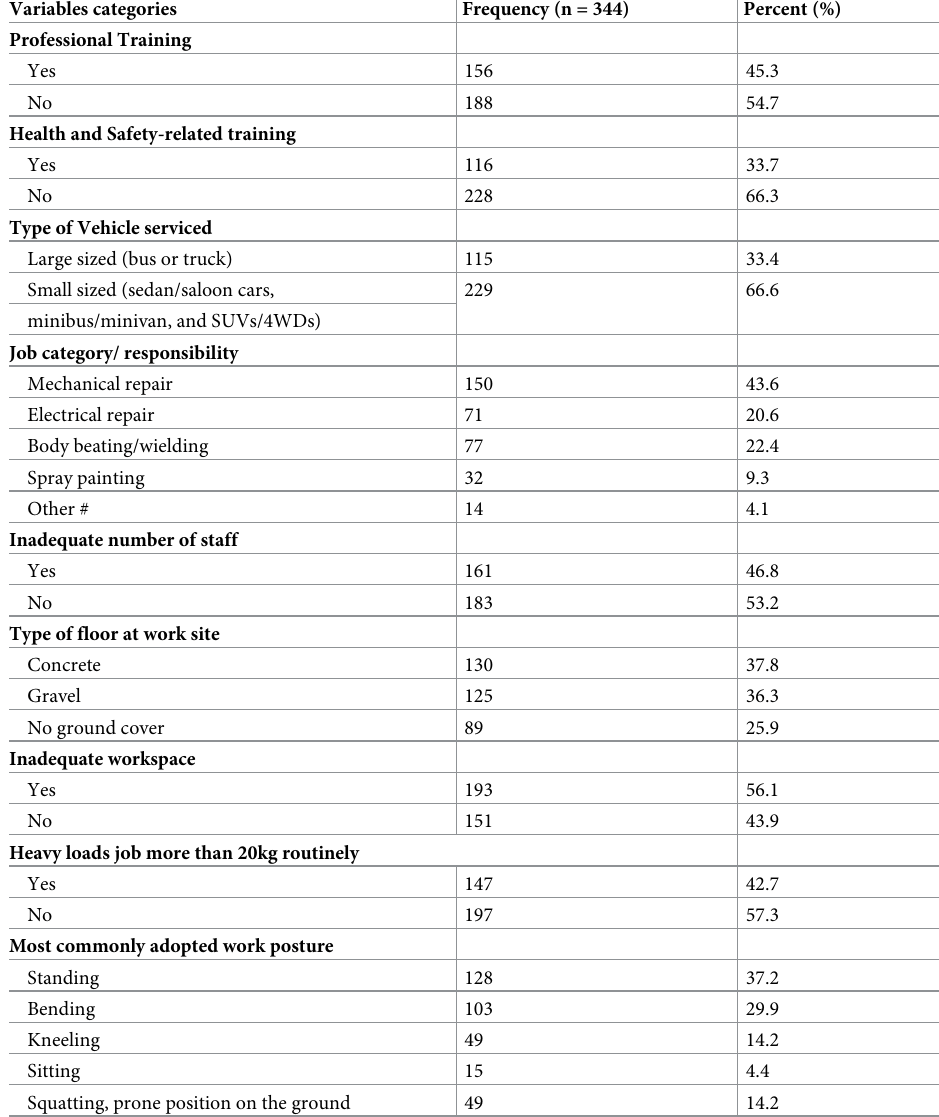
Table 2. Work environment characteristics of vehicle repair workers in Hawassa City, Ethiopia, 2019. Variables